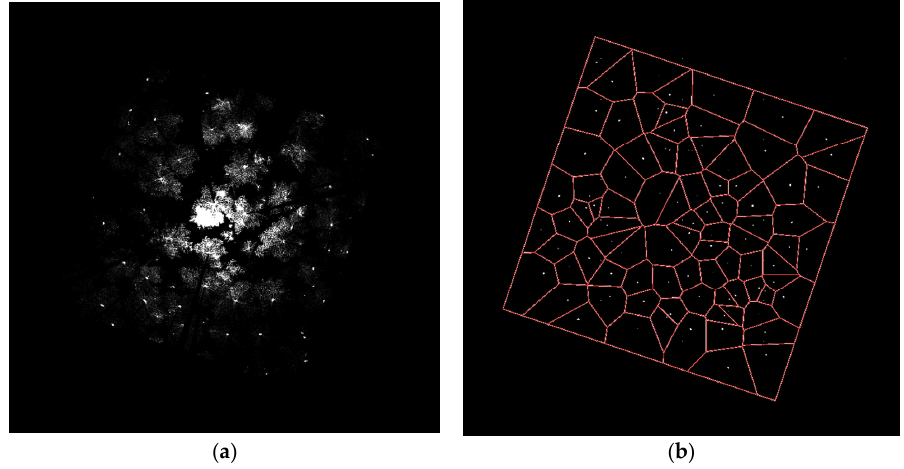
Figure 6. Stem location detection. ( a ) 2 ‐ D image directly projected from point cloud voxels as a comparison; ( b ) 2 ‐ D image projected from the convolution of 3 ‐ D directional filter and point cloud voxels, with Thiessen polygons around the extracted locations.